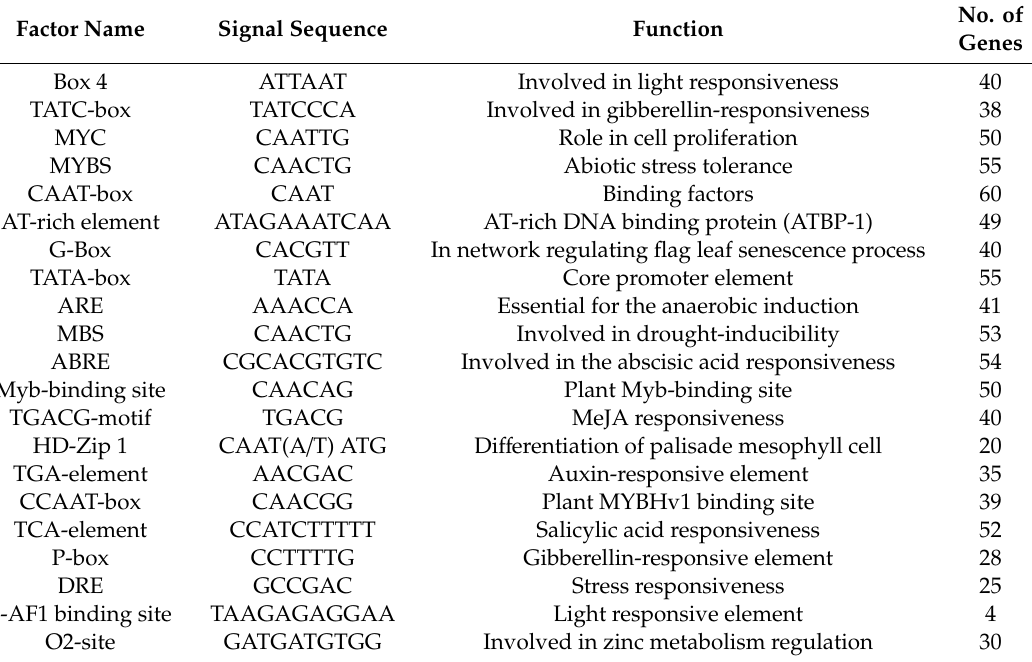
Table 2. Cis-element of genes that responded to salt